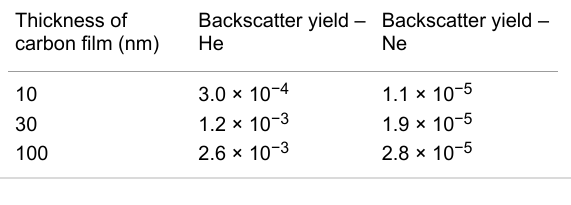
Table 1: Backscatter yield averaged over a fluence of 10 18 ions/cm 2 for carbon film irradiation by 25 keV He + and Ne + irradiation. Thickness of carbon film (nm)